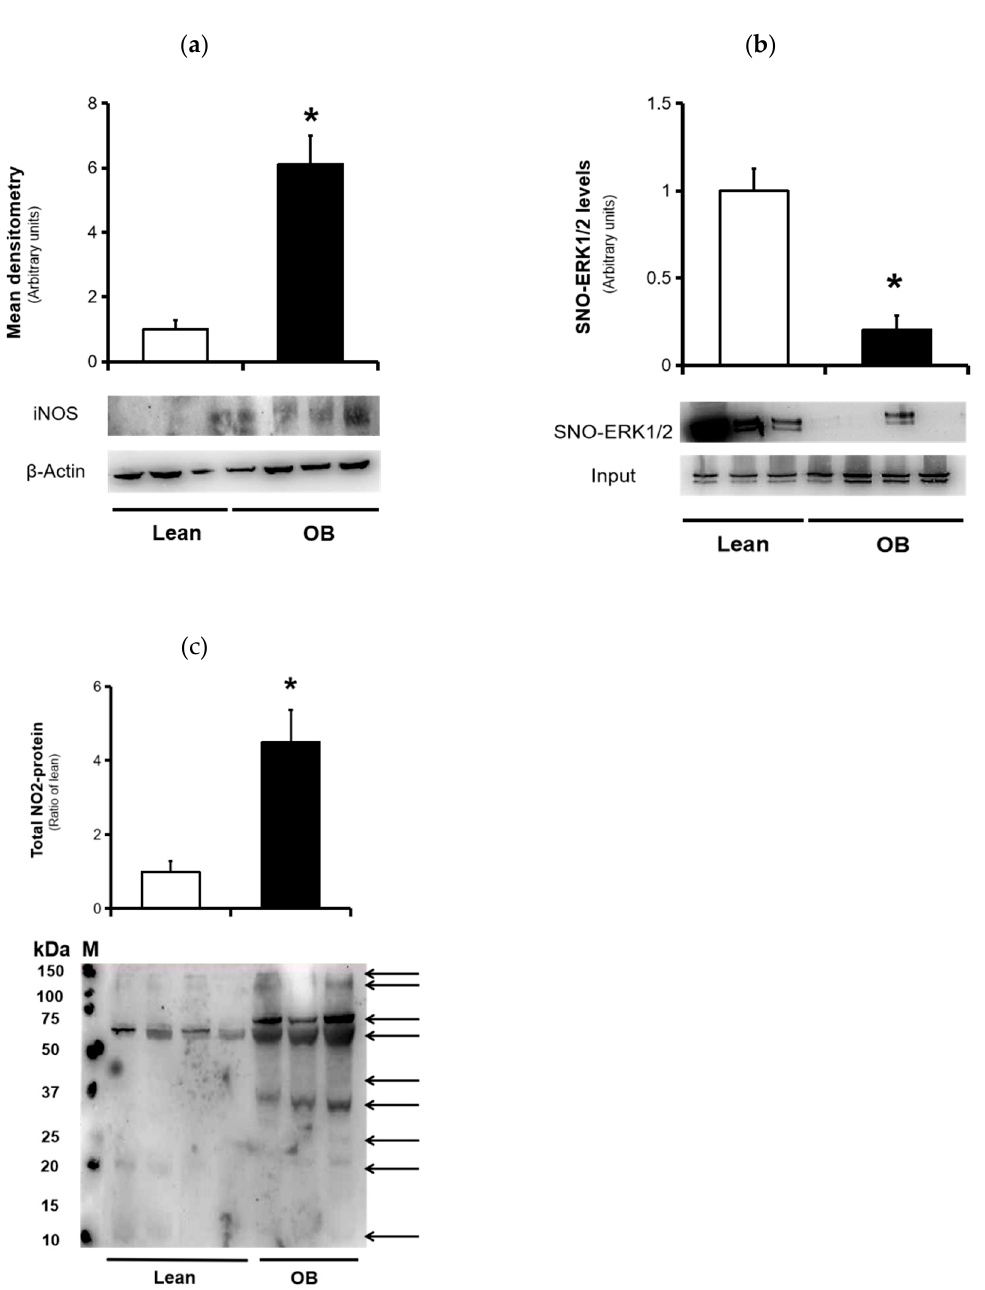
Figure 4. NO-induced nitrosative stress markers in placental samples from normal weight (lean, n = 9) and obese (OB, n = 8) pregnancies. ( a ) iNOS expression levels. This enzyme was assessed in placental protein extracts by Western blot analysis, as described in the “Material and Methods” Section. ( b ) Detection and quantification of ERK nitrosylated (SNO-ERK1,2) levels. The placental extracts were processed and subjected to the Biotin-Switch method. The biotin-labeled SNO proteins were further subjected to neutravidin capture, separated by using 10% by SDS-PAGE, and immunoblotted with an anti-ERK antibody. Total ERK were represented as total protein (input). ( c ) Detection of nitrated proteins by immunoblot analysis using antinitrotyrosine antibodies. In each lane, all nitrated proteins were counted in order to quantify the total nitration protein level for each placental sample. Molecular weight markers (M) and sizes (kDa) are shown, and also possible targets of nitrated proteins (arrows) are indicated. In all cases: top represents the mean densitometry expressed in arbitrary units and bottom shows a representative picture of all Western blots. The results were expressed as means ± SD. * p < 0.05 relative to the lean group or input. iNOS: inducible nitric oxide synthase.